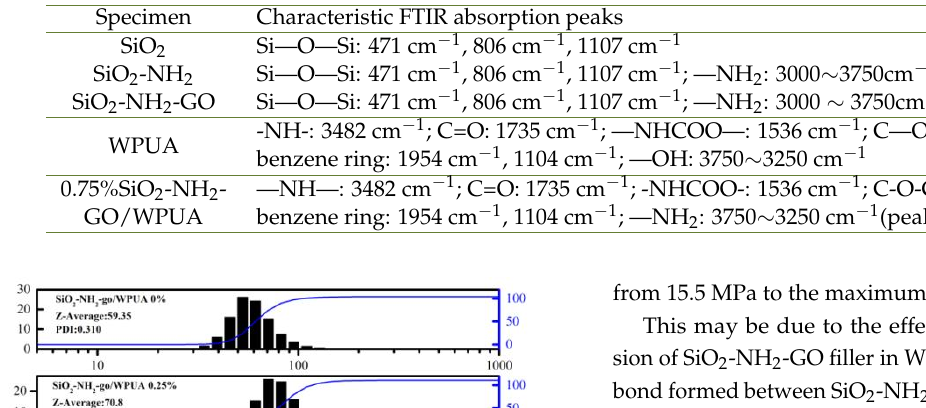
Fig. 1. FTIR spectra of SiO 2 , SiO 2 -NH 2 , SiO 2 -NH 2 -GO, WPUA and 0.75% SiO 2 -NH 2 -GO/ WPUA Table 2. Infrared characteristic absorption peaks of each sample Specimen